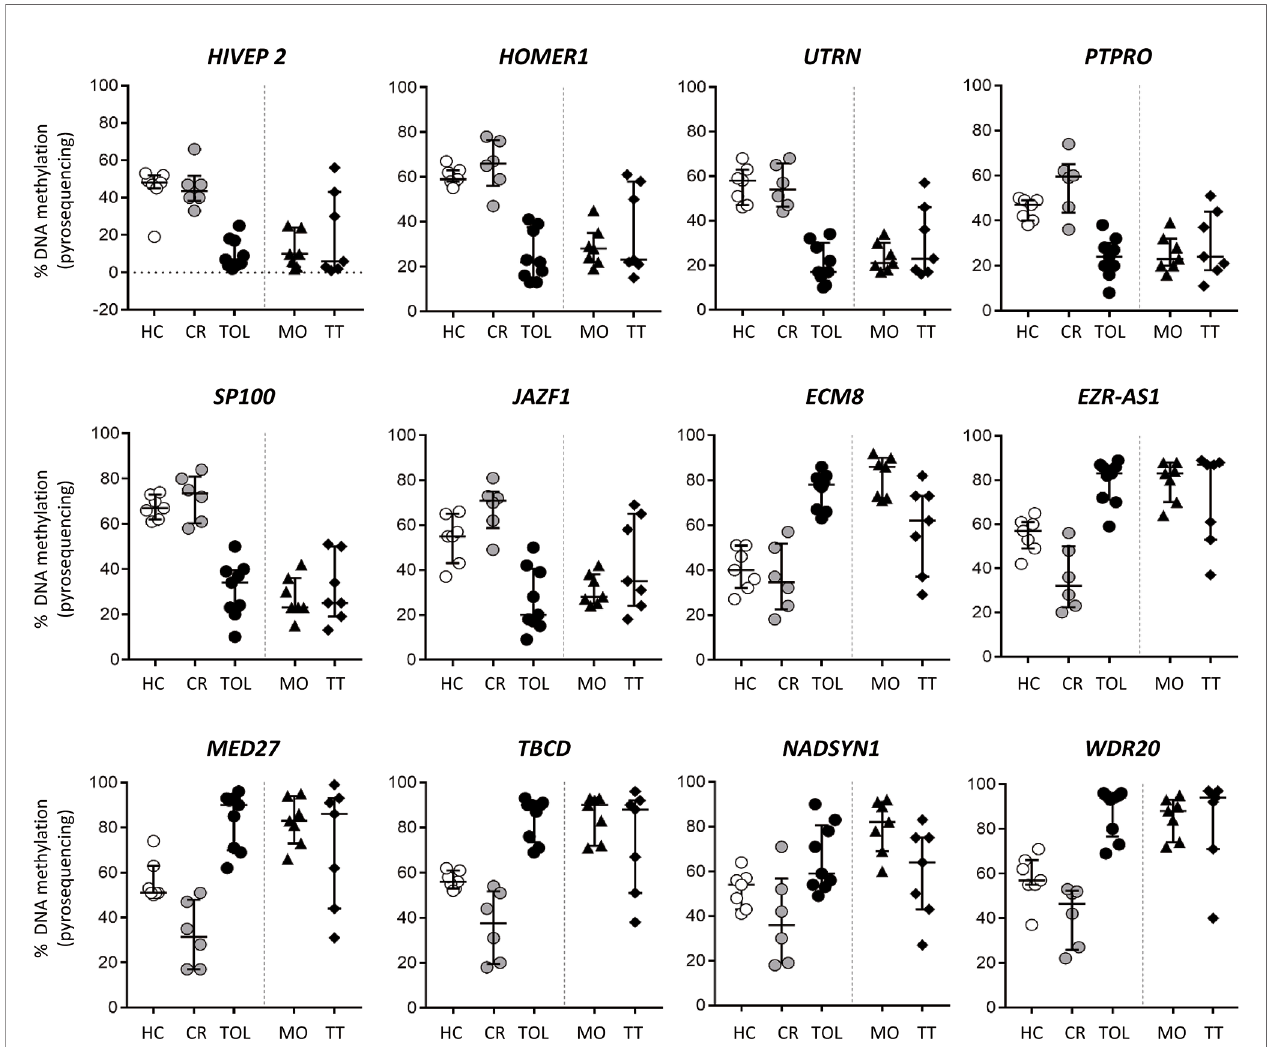
FIGURE 5 | DNA methylation analysis of kidney transplant recipients under different immunosuppressive treatment. Bisul fi te pyrosequencing of selected DMRs in operationally tolerant patients (TOL), patients with low-dose glucocorticoids as monotherapy (MO) and patients with standard triple-therapy (TT). Results are shown for each patient; lines show the median ± interquartile